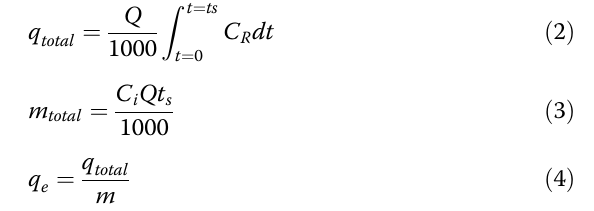
where ρ b is the bed porosity (kg m − 3 ), and f ′ ( C ) is an average value of dq/dC from an isotherm. The f ′ ( C ) was 0.029 L g − 1 according our previous studies. Table 3 Physical properties of SB and CC Physical